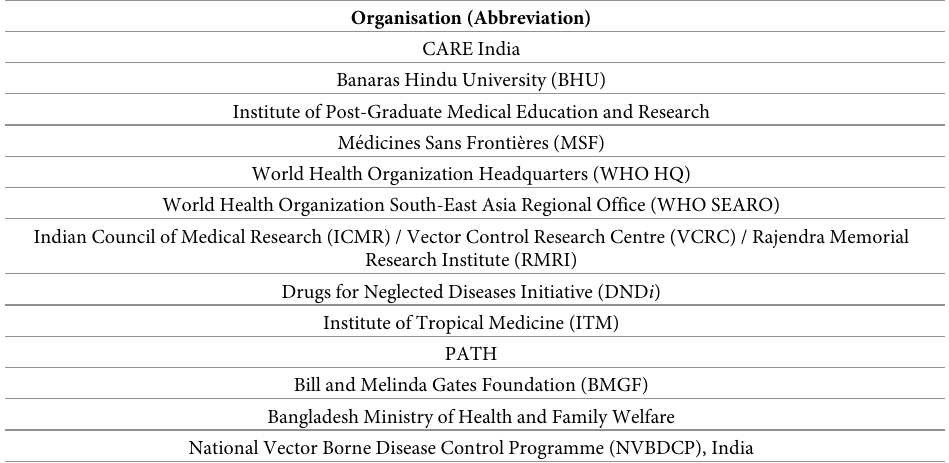
Table 3. Organisations of key informants included in the